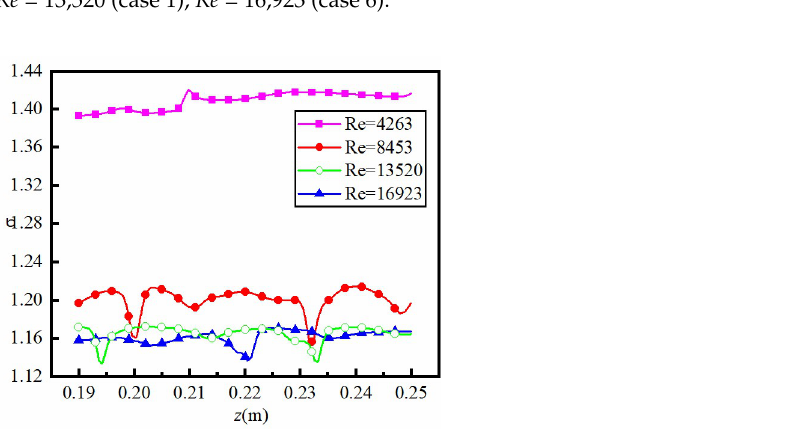
Figure 13. Distribution of standard deviation. Re = 4363 (case 4 in Table 1), Re = 8453 (case 5), Re = 13,520 (case 1), Re = 16,923 (case 6). Re = 13,520 (case 1), Re = 16,923 (case